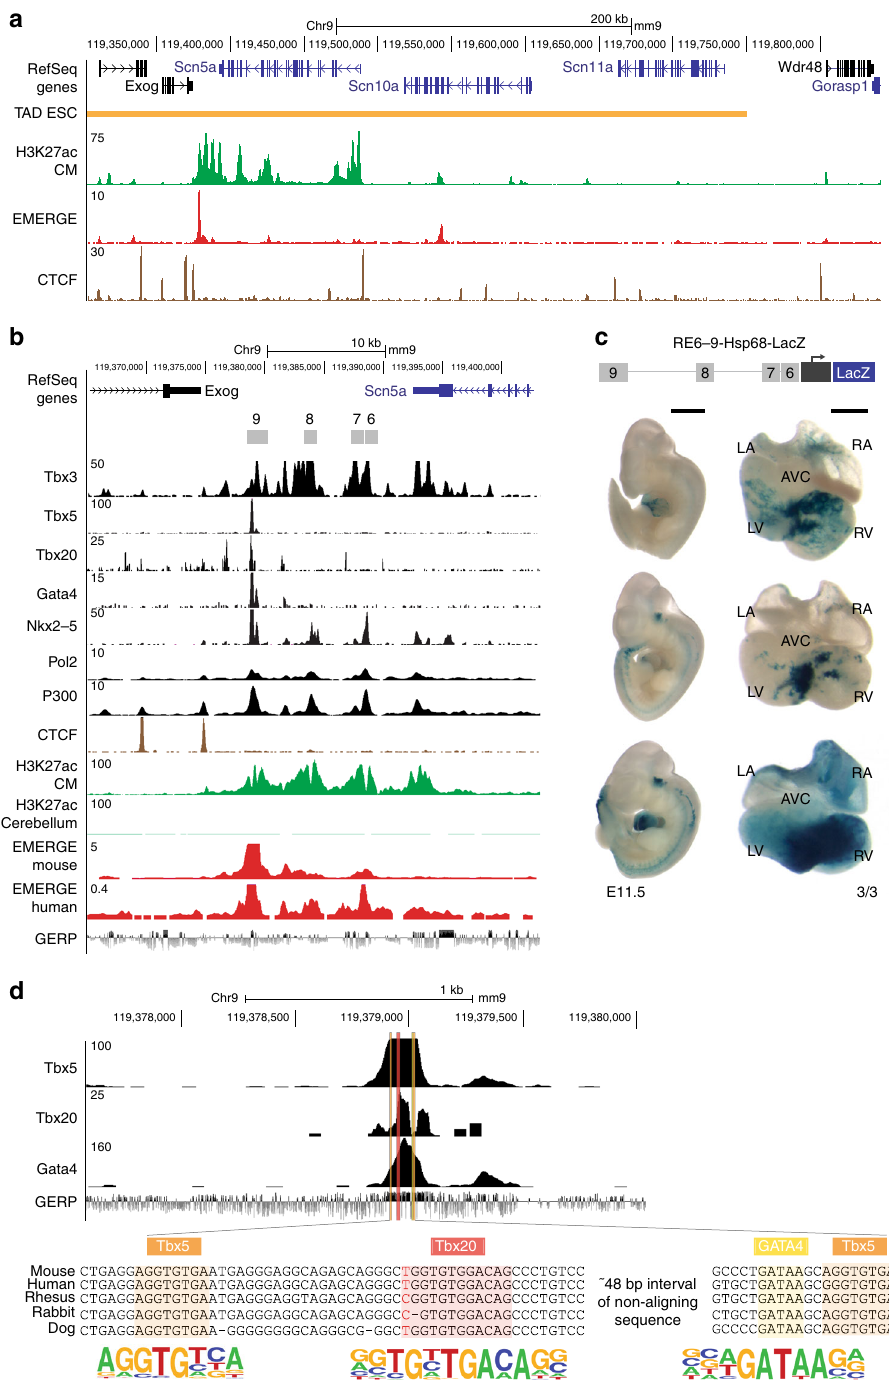
Fig. 2 Identi fi cation of a cardiac-speci fi c, multi-component ‘ super enhancer ’ in the mouse Scn5a-Scn10a locus. a UCSC browser view of Scn5a-Scn10a locus with TAD obtained from Hi-C data on mouse embryonic stem cells (ESC), cardiomyocyte-speci fi c H3K27ac ChIP 33 , mouse EMERGE 29 and CTCF ChIP adult mouse heart. b UCSC browser view of the intergenic region between Scn5a and Exog , composed of four constituent regulatory elements (RE6-9) with ChIP-seq pro fi les of Tbx3 (black), Tbx5 (black), Tbx20 (black), Gata4 (black), Nkx2-5 (black), Pol2 (black), P300 (black) from the heart. H3K27ac (green) in cardiomyocytes and cerebellum, mouse and human EMERGE 29 tracks (red) and conservation track GERP (bottom). c Dorsal view of mouse regulatory region RE6-9 in a Hsp68/LacZ enhancer reporter vector. Mouse RE6-9 (3/3) shows predominant activity in the interventricular septum and ventricles and to a lesser extent in the atria, in 2 of 3 E11.5 embryos. Black scale bars are 1 mm (embryo) and 0.5 mm (heart). d An example showing a zoomed-in view of predicted transcription factor binding sites Tbx5, Tbx20 and GATA4 in RE9 including sequence alignment between species and JASPAR consensus site. LA left atrium, LV left ventricle, RA right atrium, RV right ventricle, AVC anterior ventricular